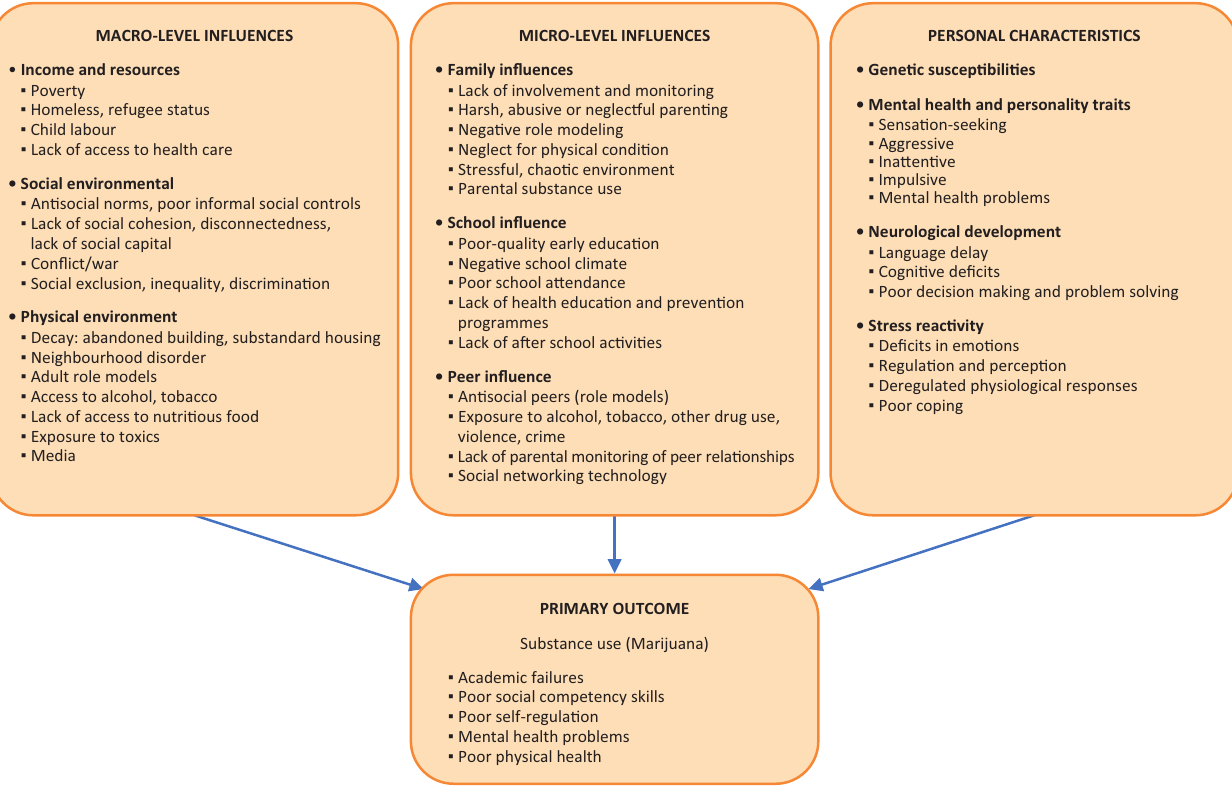
FIGURE 1: Socio-ecological model of factors influencing adolescence substance use.